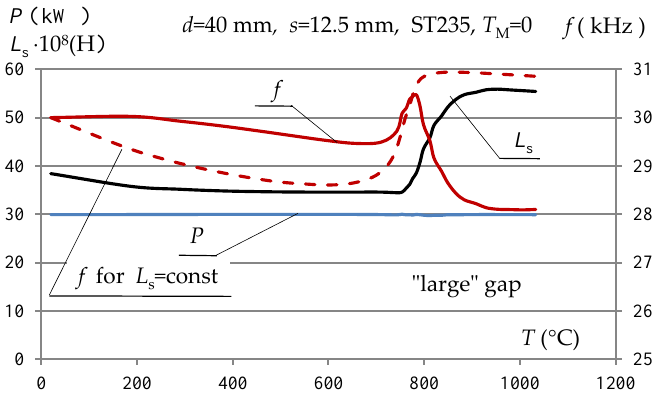
Figure 8. Changes in series inductance L s for the LLC inverter to maintain constant energy matching during the heating process, in the case of a system with a “large” inductor–charge gap.